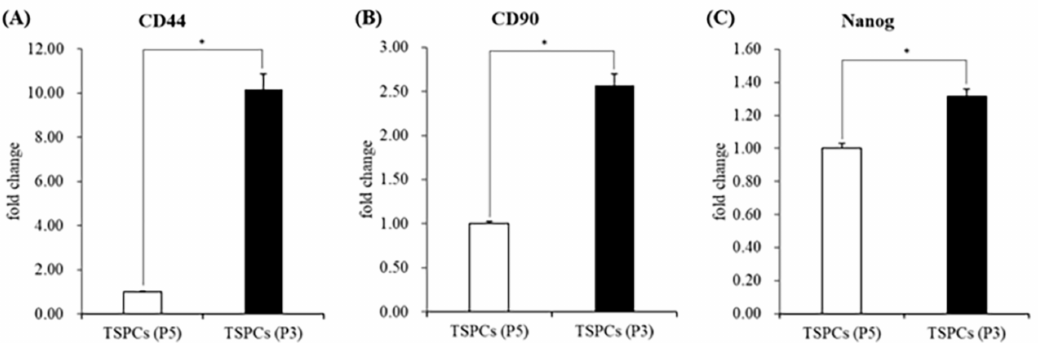
Figure 1. Identification of stemness in TSPCs by qPCR; ( A – C ) the expression of the mRNA of stemness-related marker genes ( CD44 , CD90 , and Nanog ). ( n = 3), * p < 0.05. 2.2. Proliferation and Alkaline Phosphatase (ALP) Activities of TSPCs Treated with Calcium Phosphate Granules